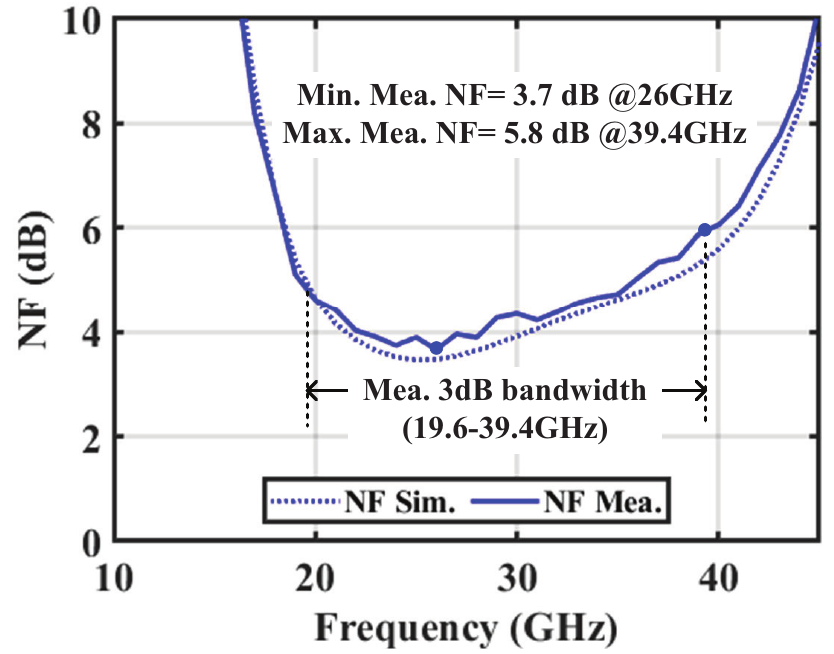
Figure 7. Simulated and measured NF of the